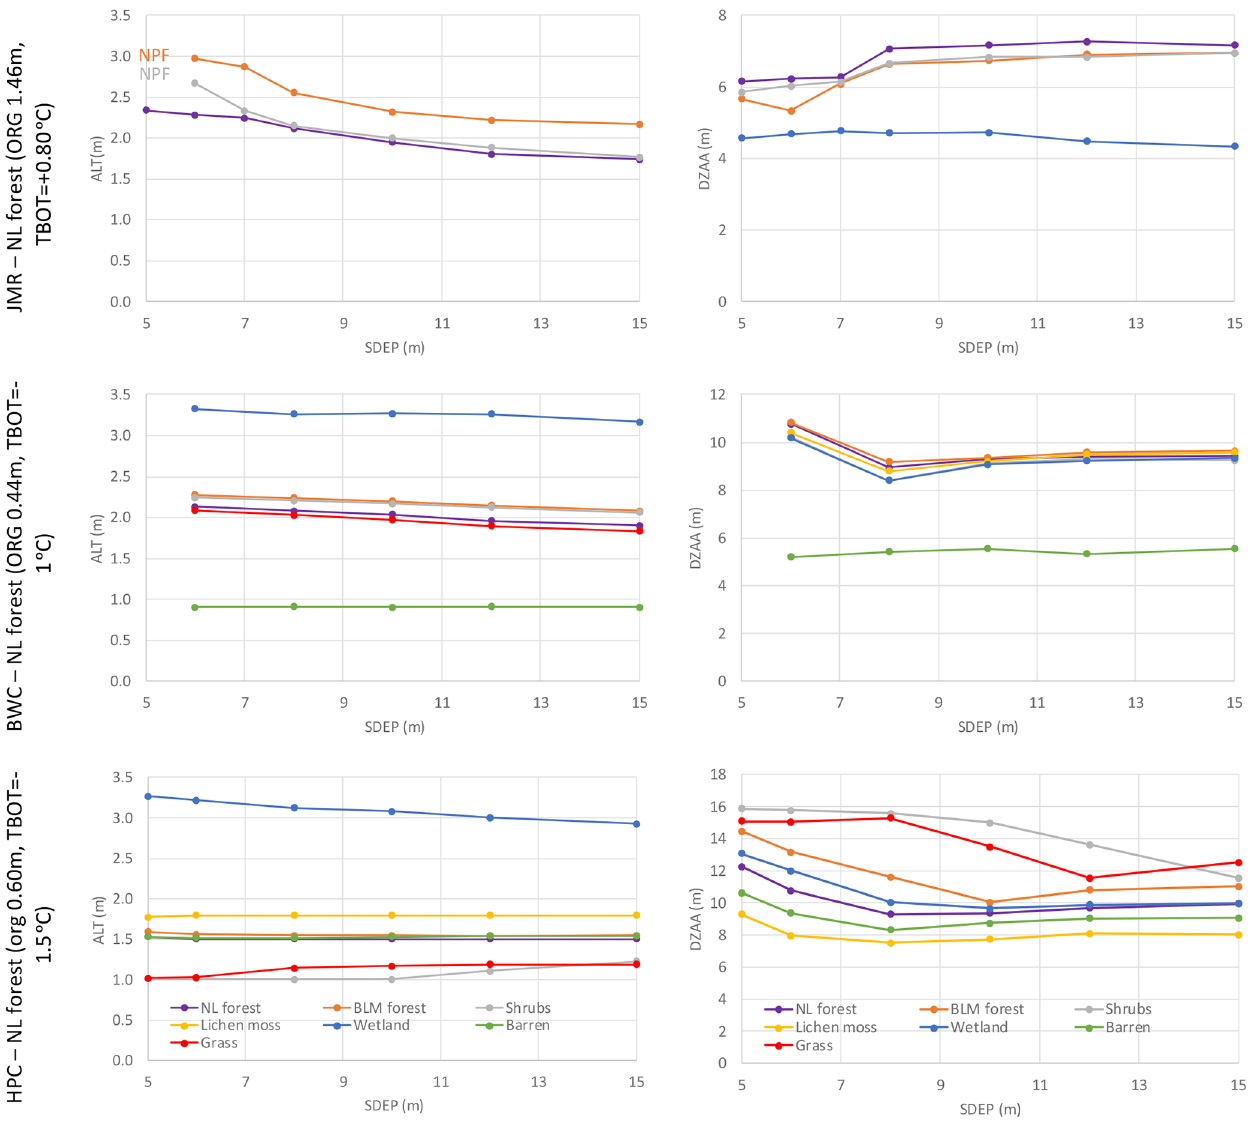
Figure 12. Impact of SDEP on the average simulated ALT and DZAA for different GRUs at the three study sites over the 1980–2016 period. NPF: no